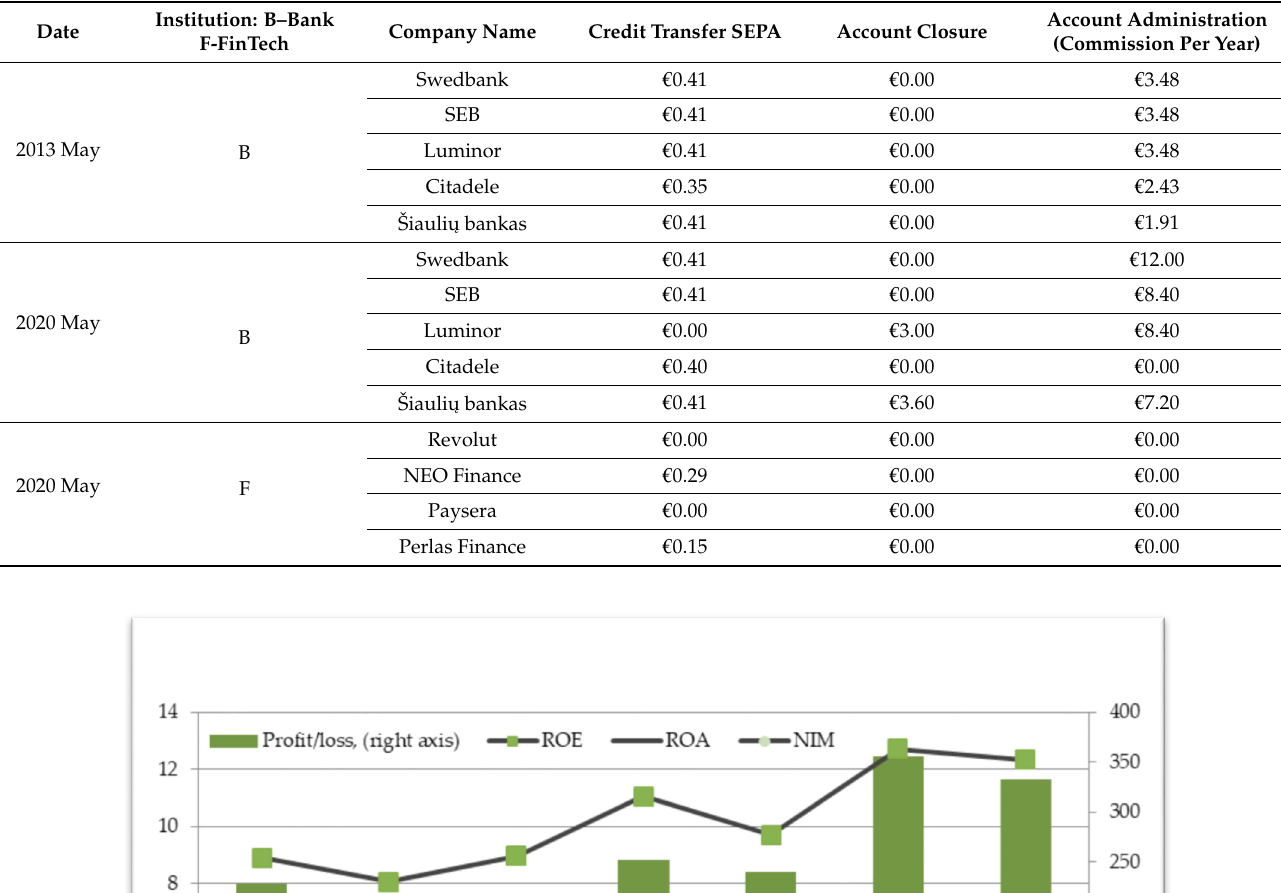
Table 3. Commission of banking and Fintech services . (Composed by the Authors using Bank of Lithuania statistics, 2020).